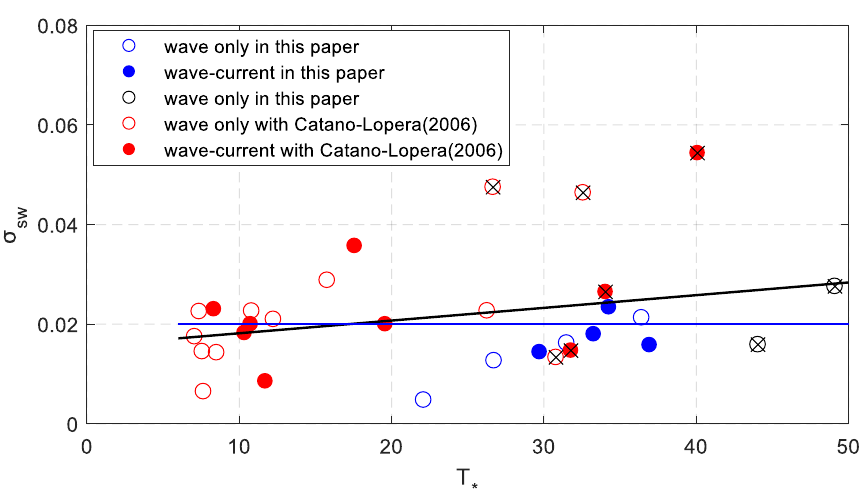
Figure 9. The relationship between the measured sand wave steepness and dimensionless shear stress. The black line is the fitting curve for all the data.